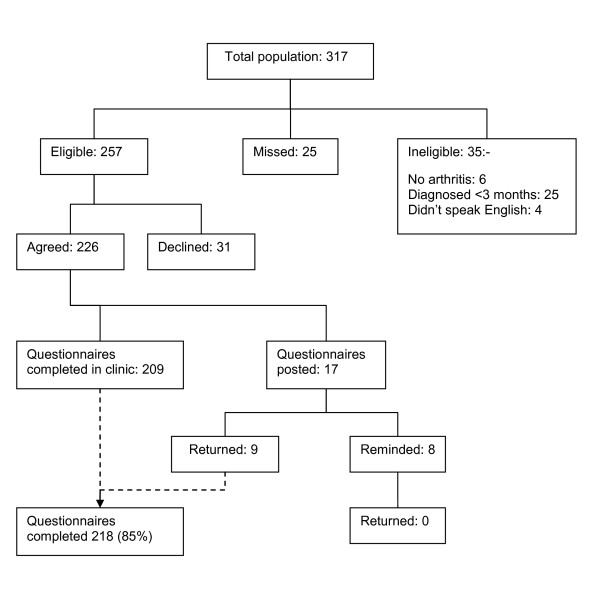
Patient recruitment.